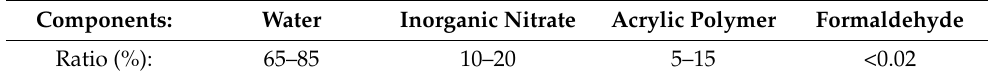
Table 3. Composition of binder